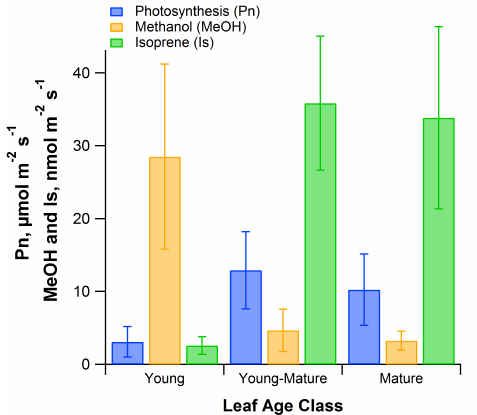
Figure 5. Average net photosynthesis rates (Pn, blue bars) to- gether with leaf emissions of isoprene (Is, green bars) and methanol (MeOH, orange bars) for six V. guianensis individuals. For each individual, volatile emissions and net photosynthesis rates were de- termined from young, young mature, and mature leaves. Error bars represent ± 1 standard deviation (six individuals, one branch per individual, one young, one young mature, and one mature leaf per branch). Pn was determined by a portable photosynthesis system (LI-6400XT, LI-COR Inc., USA), and Is and MeOH by a proton transfer reaction/mass spectrometer (PTR-MS, Ionicon Analytik,